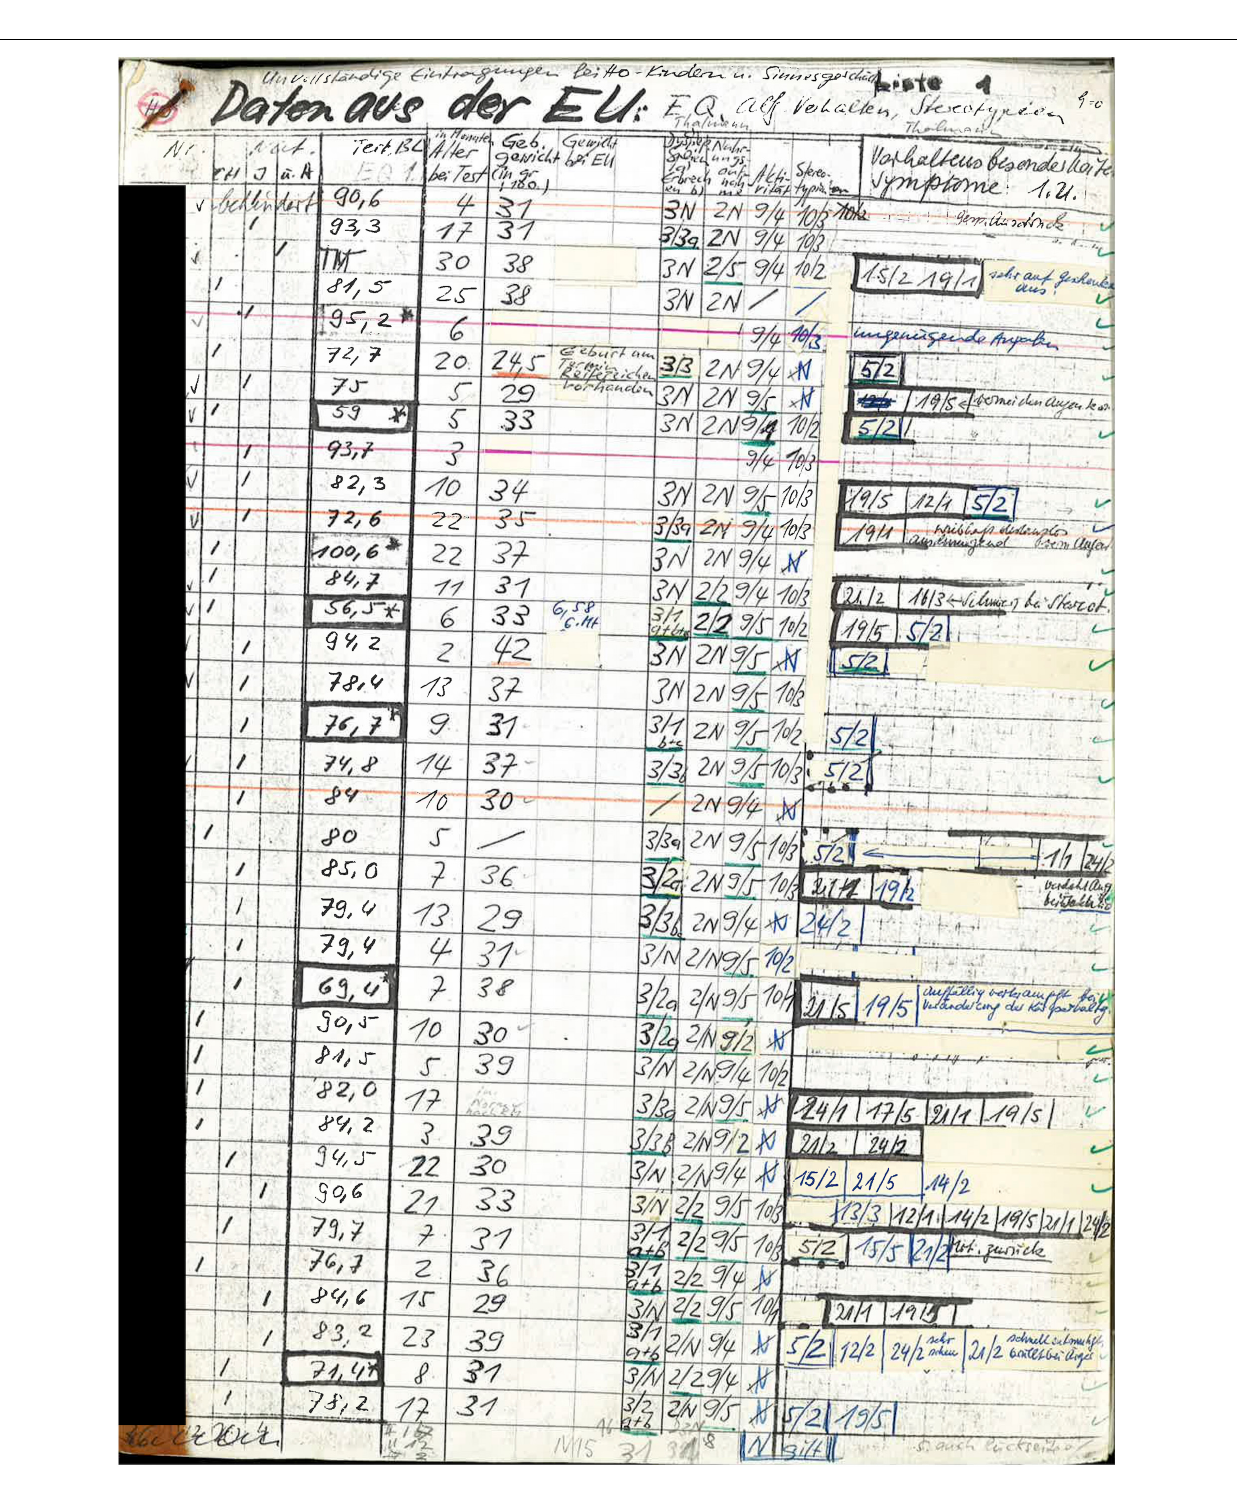
consisted of N = 143 children. The distribution of gender, nationality, and marital status of the mother within the group of children examined was, according to Meierhofer